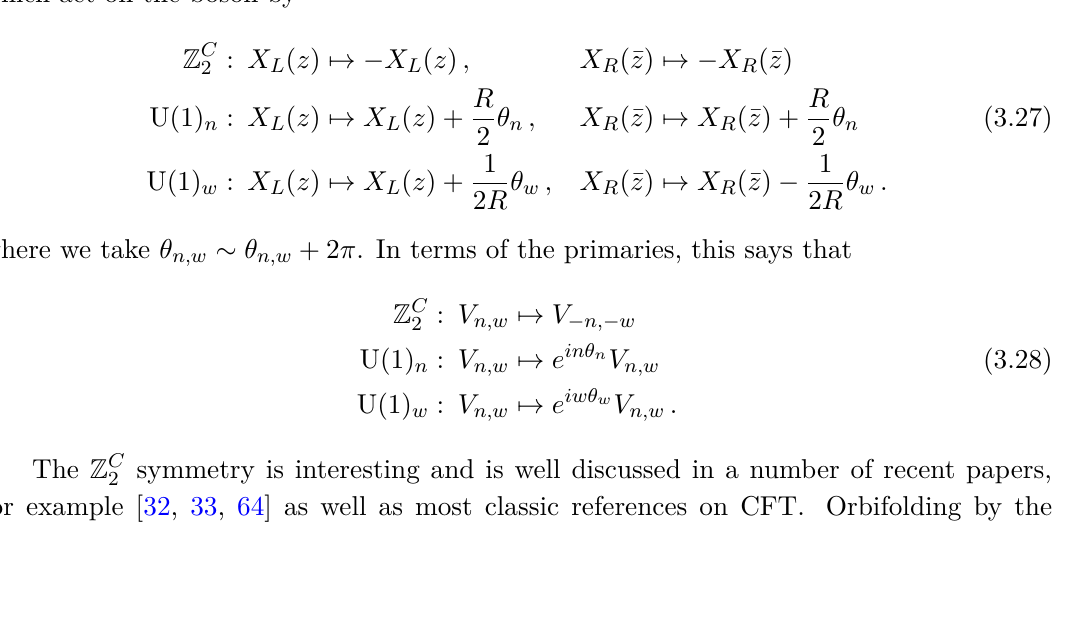
Figure 11 . On the left, the orbifold groupoid for the bosonic topological manipulations for a theory with Z Z f symmetry. Lines connect two theories related by gauging the bosonic Z 2 × 2 right, we superimpose this graph with the results from the gauging in Z the entire orbifold groupoid. The bosonic gauging is marked in blue and red depending on if it originates from a bosonic or fermionic theory respectively, GSO projections are marked in